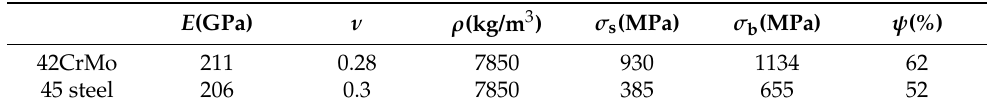
Table 2. Mechanical properties of 42CrMo and 45 steel.